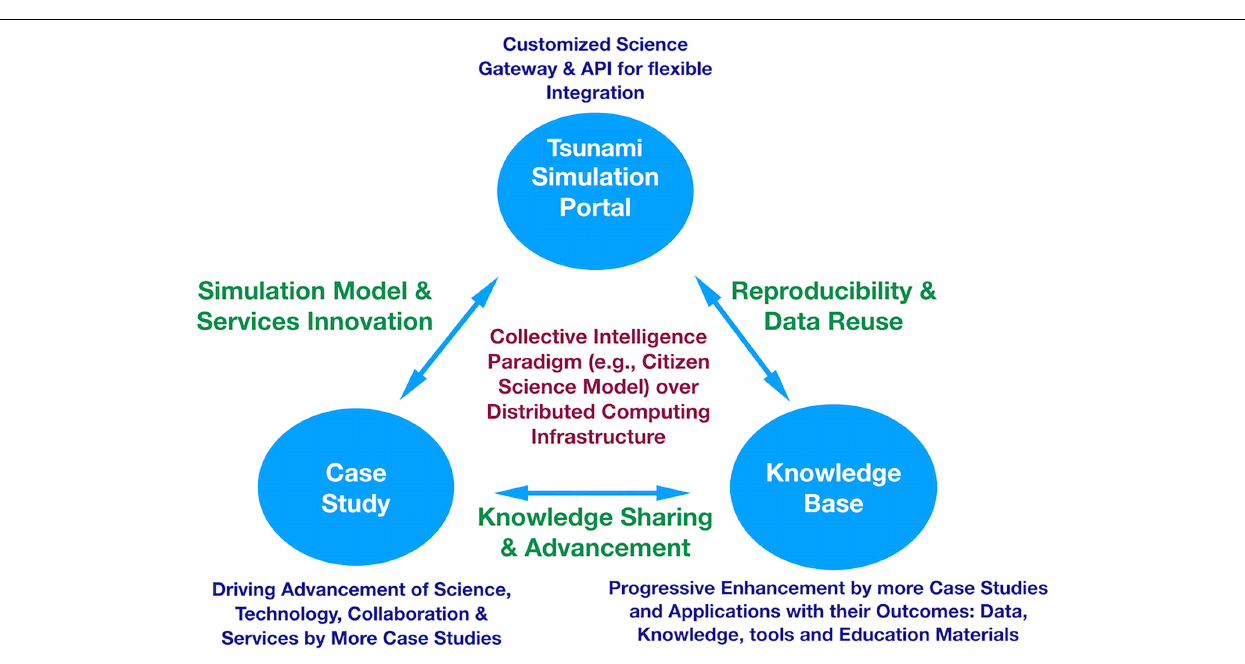
FIGURE 8 | Framework integrating the deeper understanding approach and the citizen science